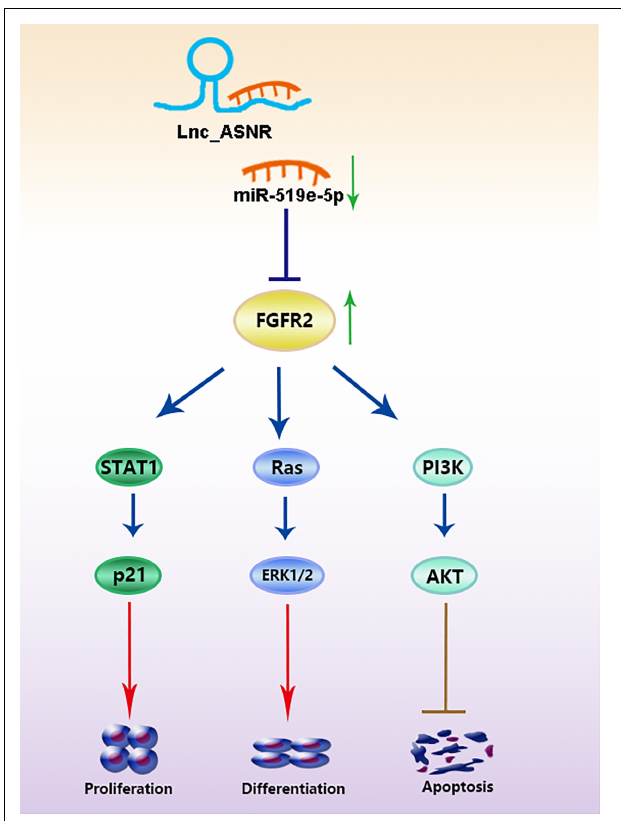
FIGURE 8 | Lnc_ASNR acted as a ceRNA for miR-519e-5p promoting GC development by regulating